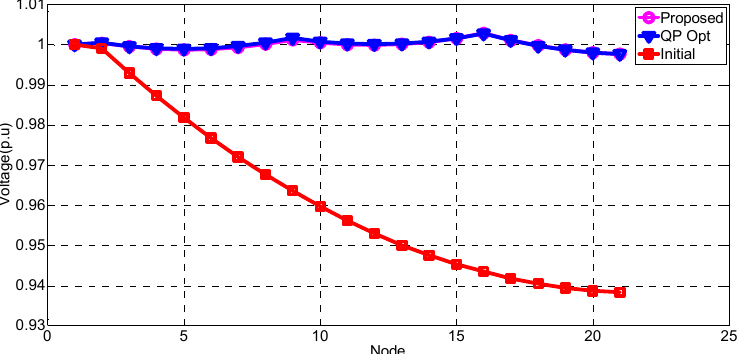
Figure 9. Flowchart of the proposed reactive power control method for voltage flattening.